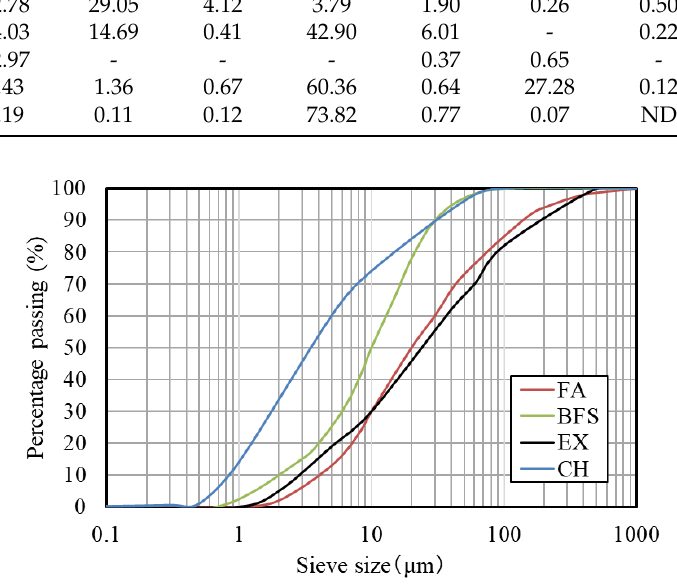
Figure 1. Particle size distribution of materials for